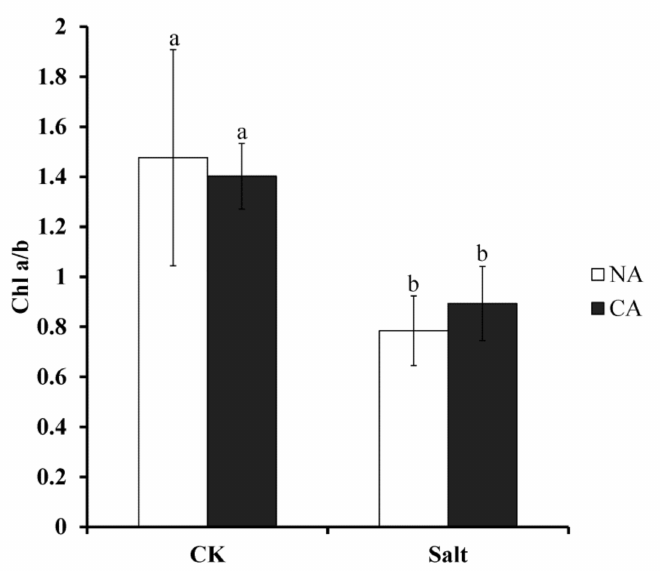
Figure 3. Chlorophyll (Chl) a / b ratio of bermudagrass under di ff erent treatments. Mean values and standard deviation (SD) were calculated from three independent experiments. Di ff erent letters indicate significant di ff erence ( p < 0.05) based on one-way analysis of variance (ANOVA), Duncan’s multiple range test. Bars show SD. CK = control; NA = non-cold treatment; CA = pre-cold treatment for 6